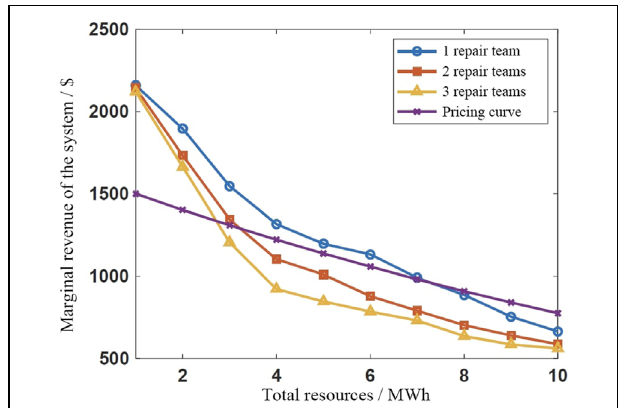
FIGURE 14 | Marginal revenue of purchase of power supply resources (100